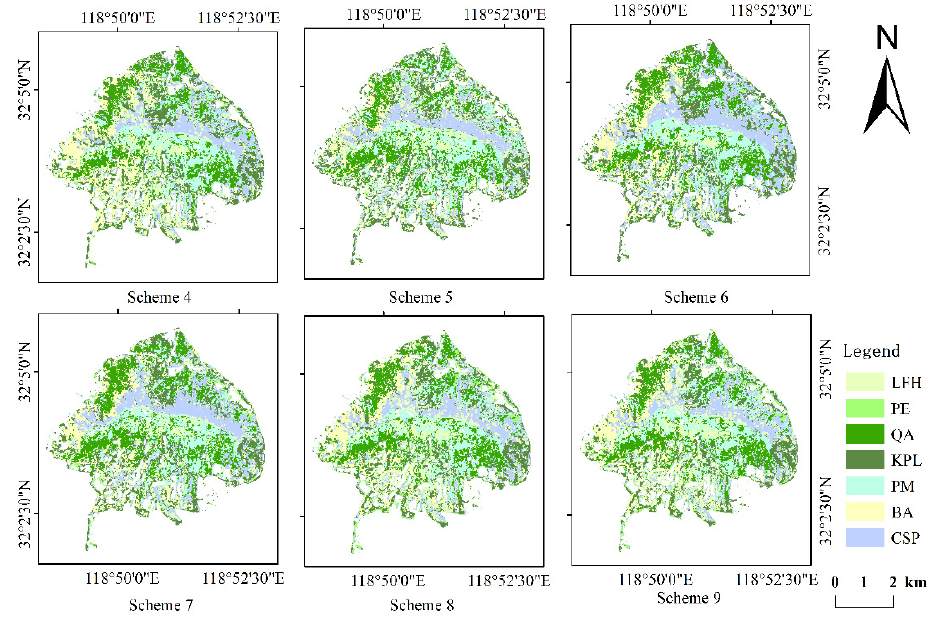
Figure 5. Classification results for different schemes .